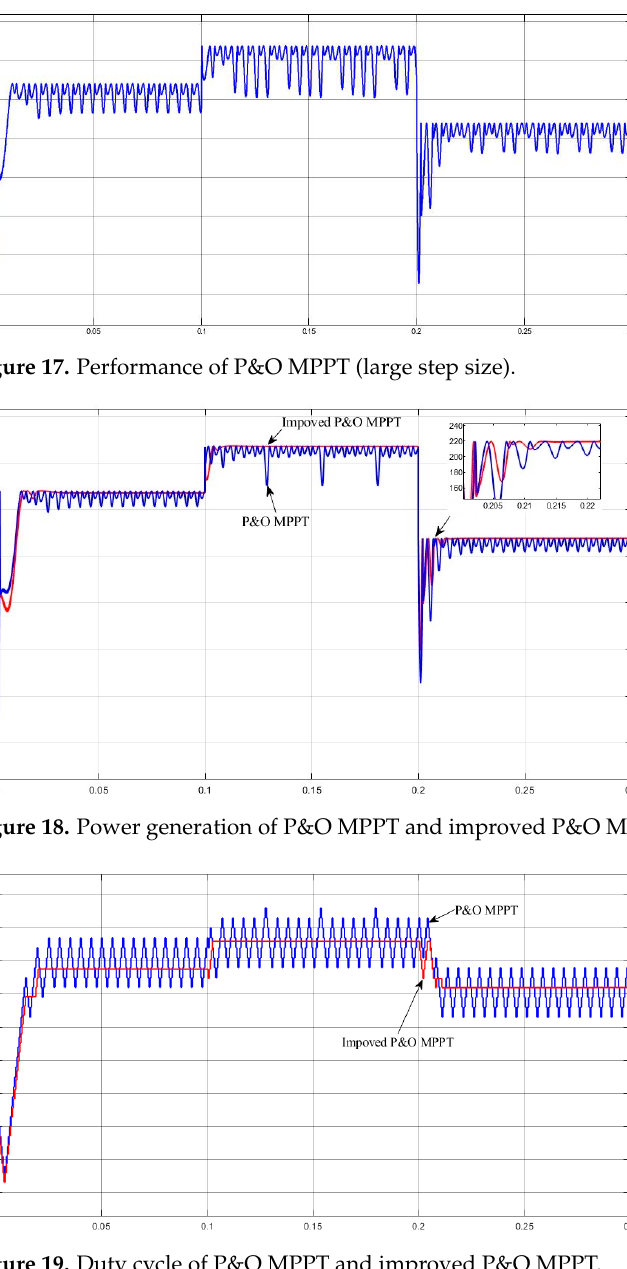
Figure 16. Performance of P&O MPPT (small step size).